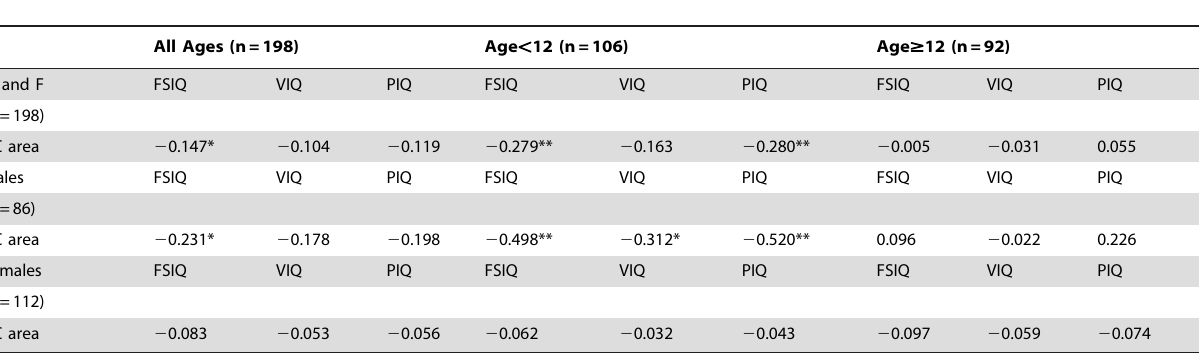
Table 3. Correlations between total corpus callosum midsagittal area and FSIQ, VIQ, and PIQ correcting for total brain volume and